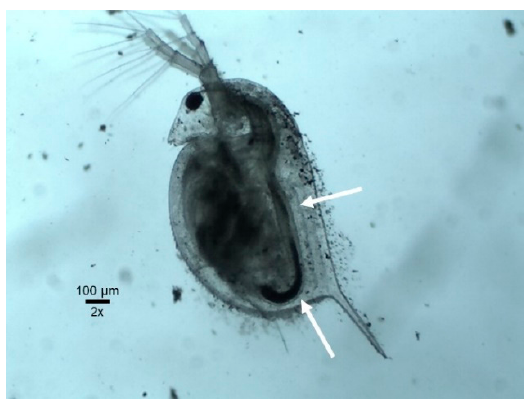
Figure 4. Photograph of dead Daphnia magna . Digestive tract filled with BC particles as indicated by the arrows.